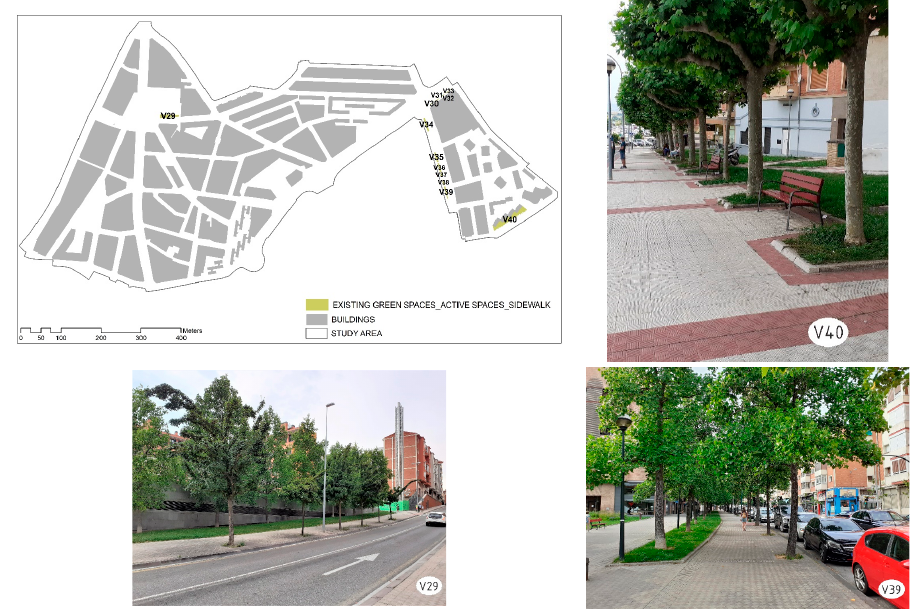
Figure 7. Green transit spaces.